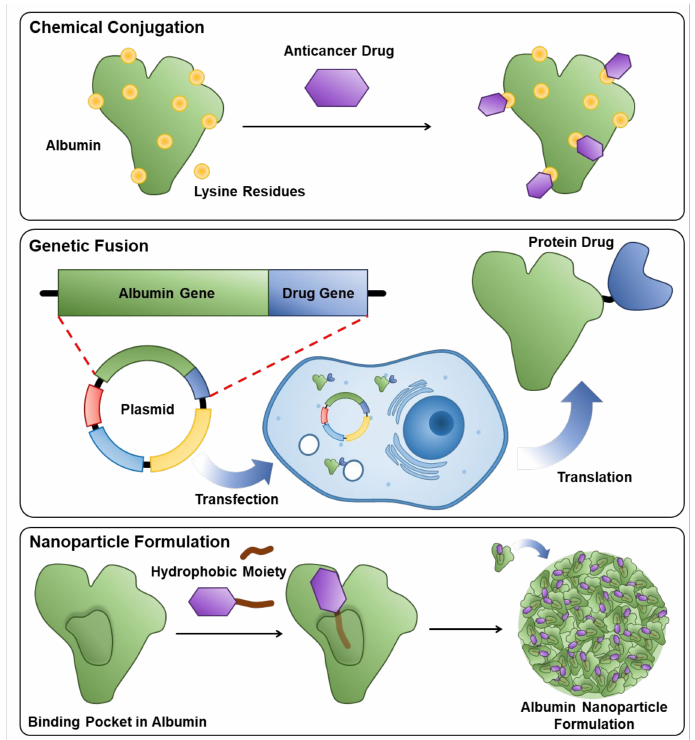
Figure 1. Schematic illustrations to explain three methods for the preparation of exogenous albumin- bound drug